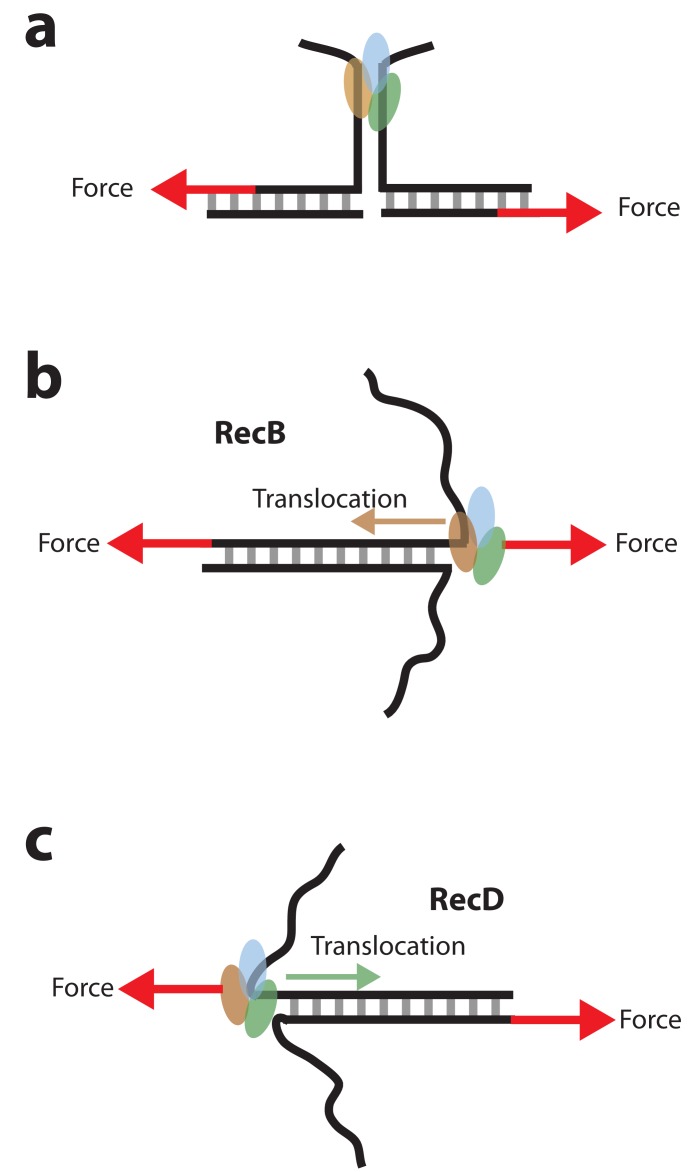
Schematic description of the force effect.(a) During unwinding of the ‘stem’, the force acts on the DNA fork, not on RecBCD, and is below the force required to ‘unzip’ the DNA. (b–c) As RecBCD finishes unwinding the stem and each subunit engages its track, an effective force acts pulling the DNA on one side and each subunit on the other, in the direction opposite to its translocation. This opposing force functions as an inhibitor of the translocation step.